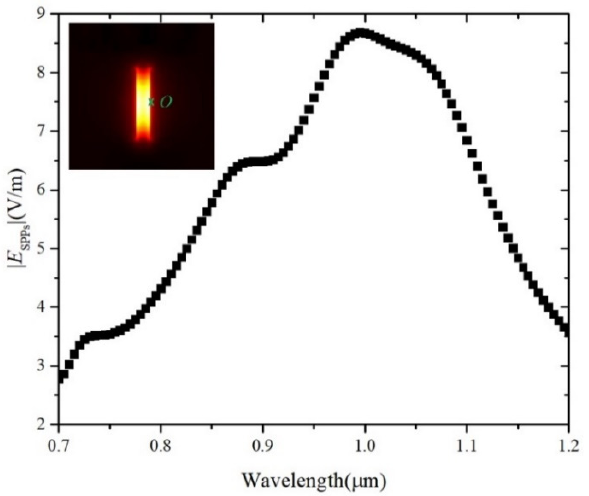
Figure 9. The relationship between the SPP electric field intensity at point O and the incident wavelength.